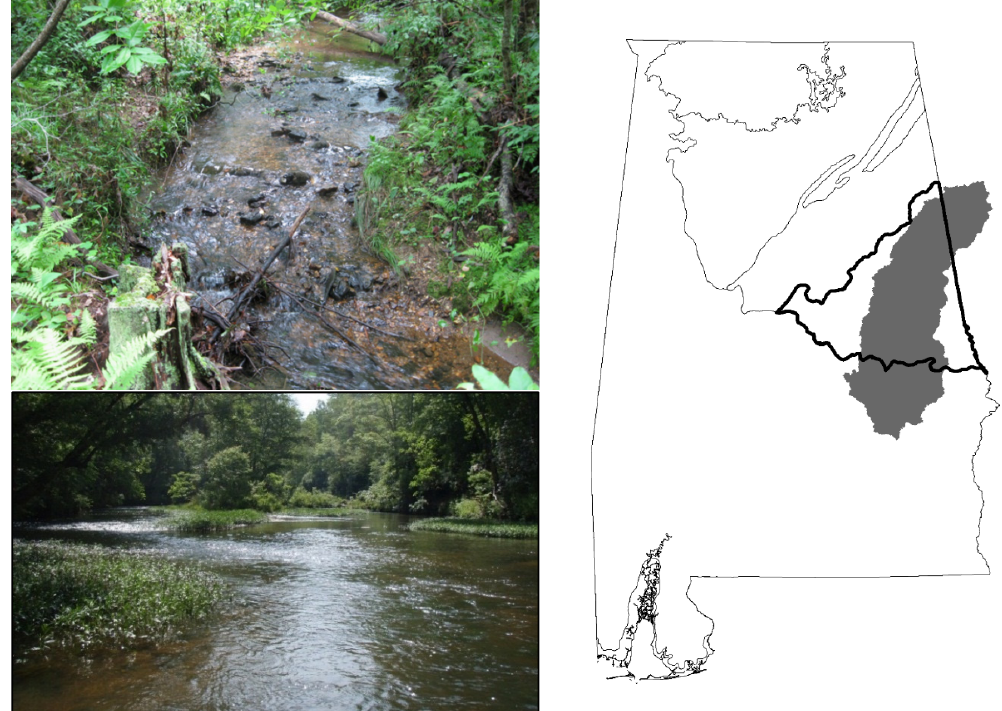
Figure 1. Ecoregions of Alabama (lines) and the Tallapoosa River basin (shaded). The Piedmont ecoregion is within bold lines. All 21 study sites were in the Piedmont ecoregion of the Tallapoosa basin. Upper photo typifies conditions at a small stream (0.4 km 2 drainage area) and the lower photo typifies conditions at a larger stream site (118 km 2 drainage area).